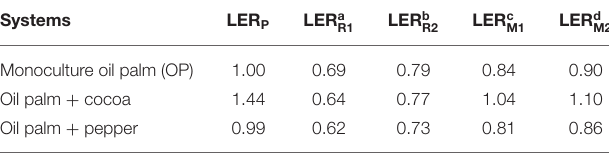
TABLE 8 | Multifunctional land equivalent ratio LER M on the basis of land sparing indicator LER P and land sharing indicator LER R (for provisioning and regulating functions, respectively) for three different land use